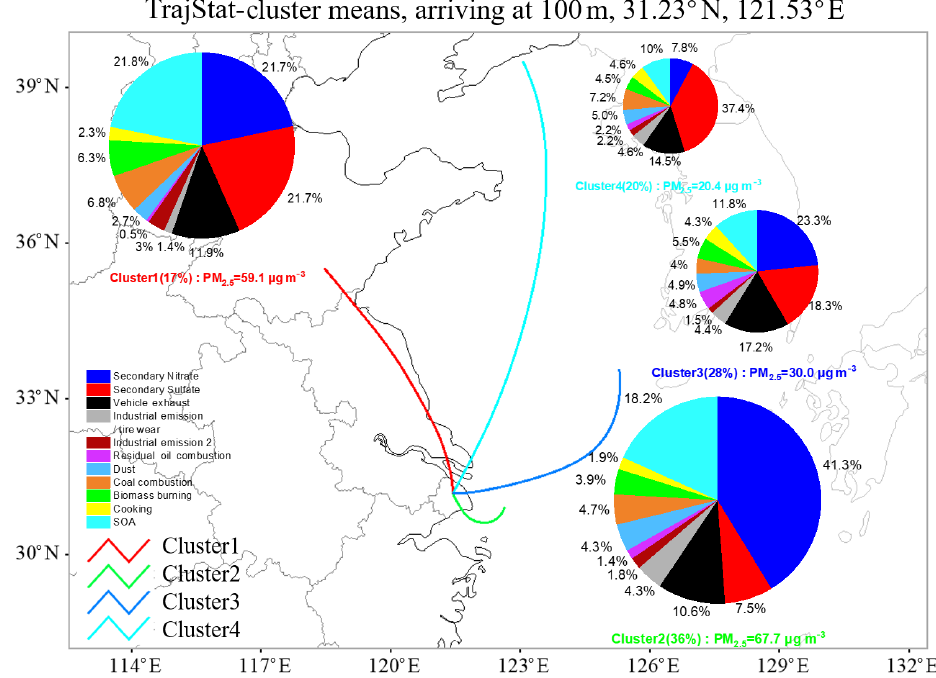
Figure 7. MM-PMF-resolved source factor contributions to PM 2 . 5 in different clusters during the sampling period. The colored lines in the map show the backward-trajectory-cluster means of the four clusters resolved by the TrajStat model. The percentage in parentheses after each cluster is the contribution of the corresponding cluster to all trajectories. The pie chart components represent the percentage contributions of individual source factors. The size of the pie chart is proportional to the total PM 2 . 5 mass in each